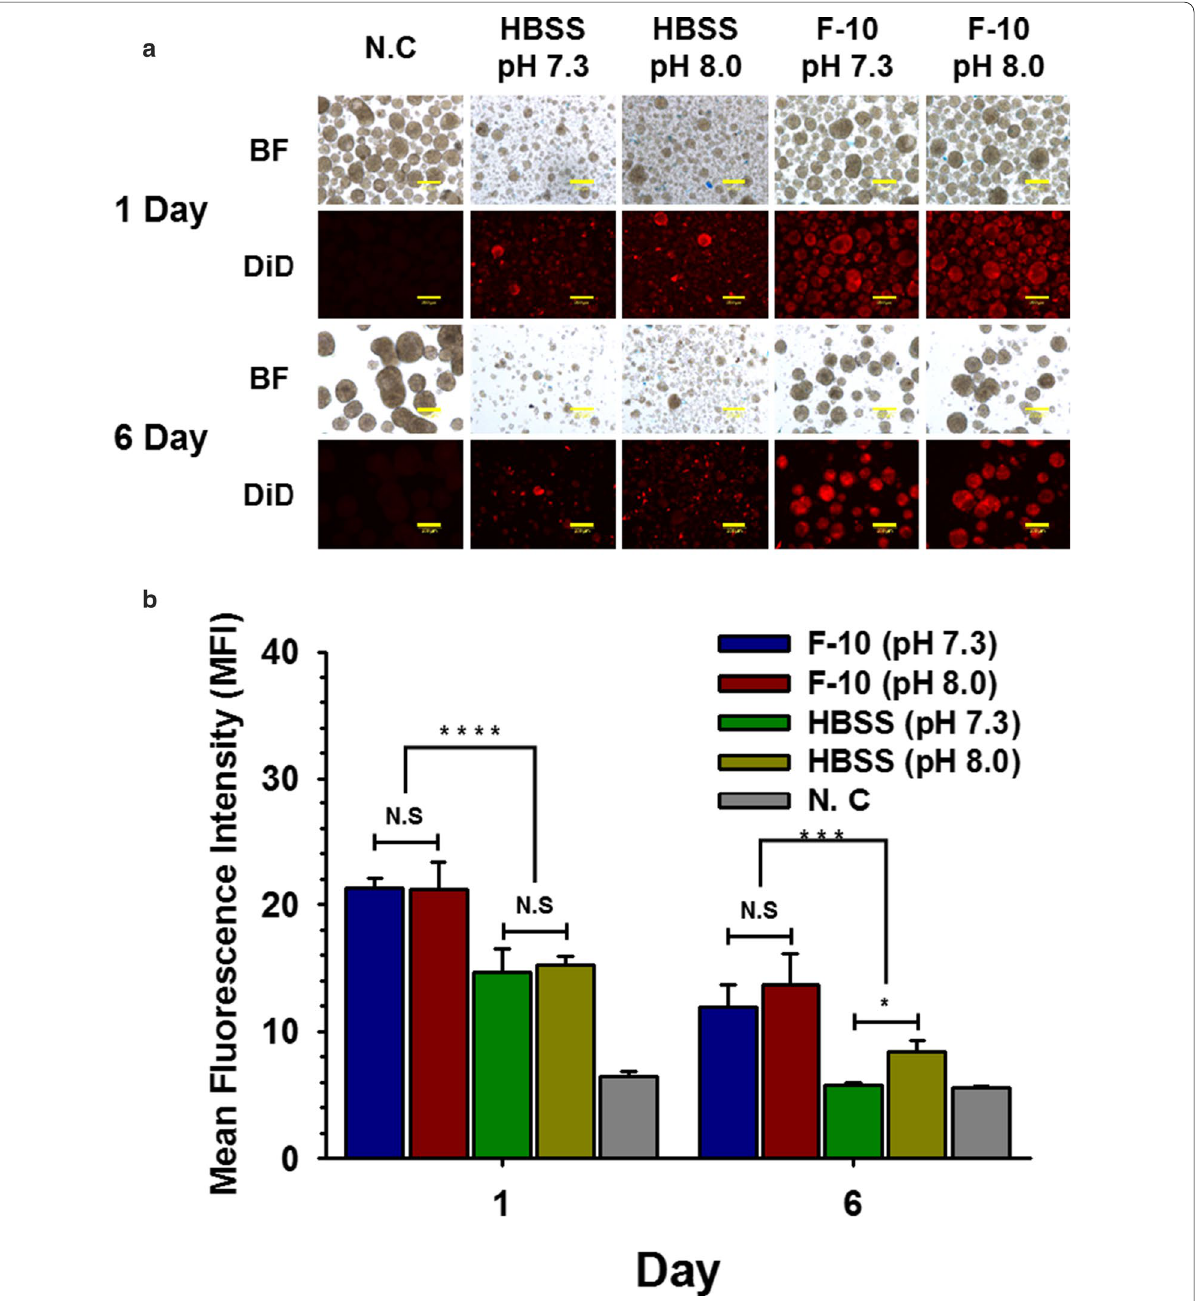
Fig. 2 Comparisons of coating efficiency of nano‑encapsulation in various reaction buffers at 1 and 6 days. Comparisons of coating efficiency of nano‑encapsulation in various reaction buffers. a Nano‑encapsulated NPCCs in HBSS (pH 7.3 and pH 8.0) or F‑10 (pH 7.3 and pH 8.0) using DiD‑conjugated NHS‑PSome (BF; bright field). The scale bars represent 200 um; b MFI of nano‑encapsulated NPCCs in HBSS (pH 7.3 and pH 8.0) or F‑10 (pH 7.3 and pH 8.0) using DiD‑conjugated NHS‑PSome (all groups; n **** p < 0.0001 versus other